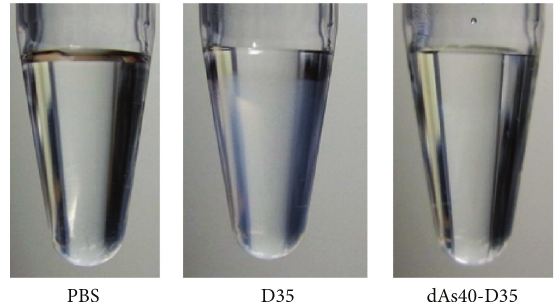
Figure11:5 󸀠 additionofdAs40sequencetoD35alsopreventsvisible large aggregate formation in PBS. The indicated ODNs were initially dissolvedindistilledwaterataconcentrationof10 mg/mL(allODNs were completely solubilized with water and the solutions were clear) and further diluted with PBS at a final concentration of 1.0 mg/mL. Solutions were stored at 4 ∘ C for at least 18 hours and then images were captured. D35 developed visible white turbidity during this incubation. In contrast, dAs40-D35 did not develop visible white